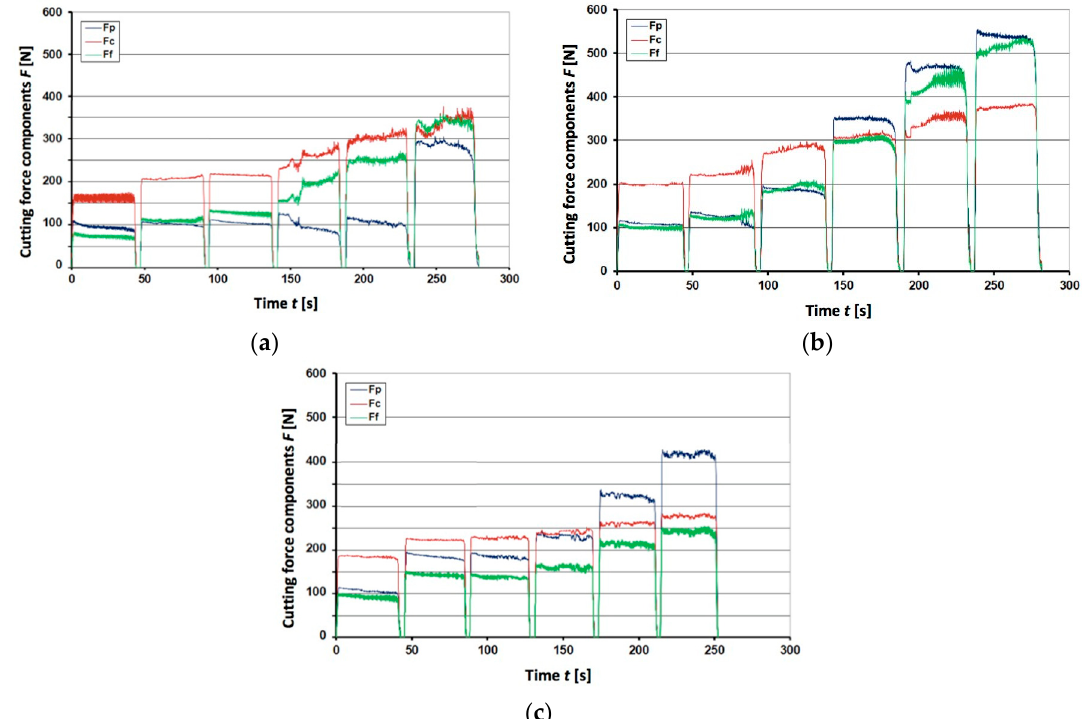
Figure 6. Registered force components F p , F c , and F f for the Re + implanted at dose 2 ×·10 17 ion/cm 2 insert IS9: ( a ) 1st edge; ( b ) 2nd edge; ( c ) 3rd edge.